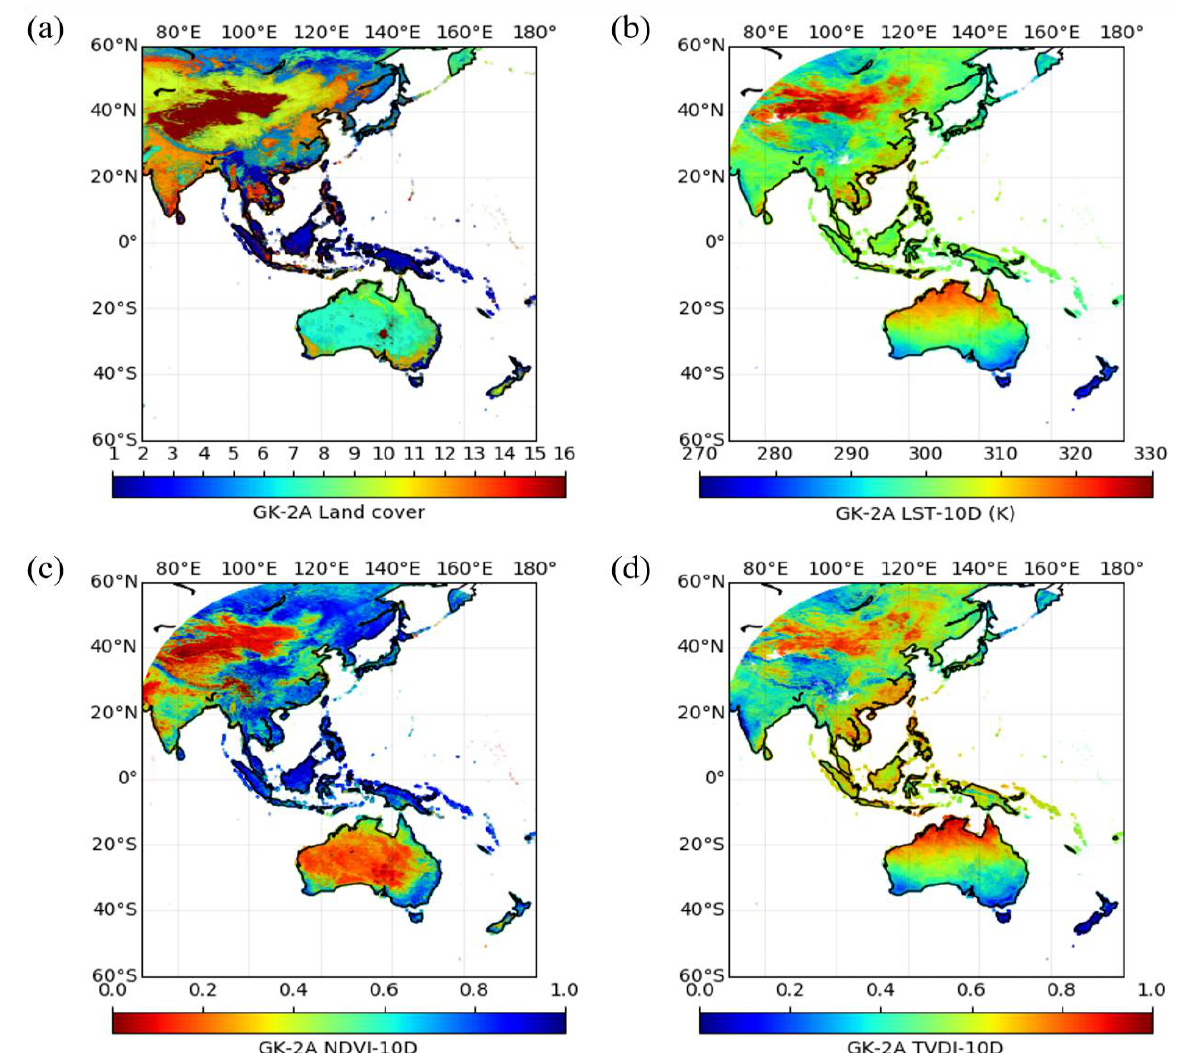
Figure 5. Spatial distributions of GK-2A ( a ) land cover and 10-day averaged ( b ) LST , ( c ) NDVI , and ( d ) TVDI on 19 July 2020.